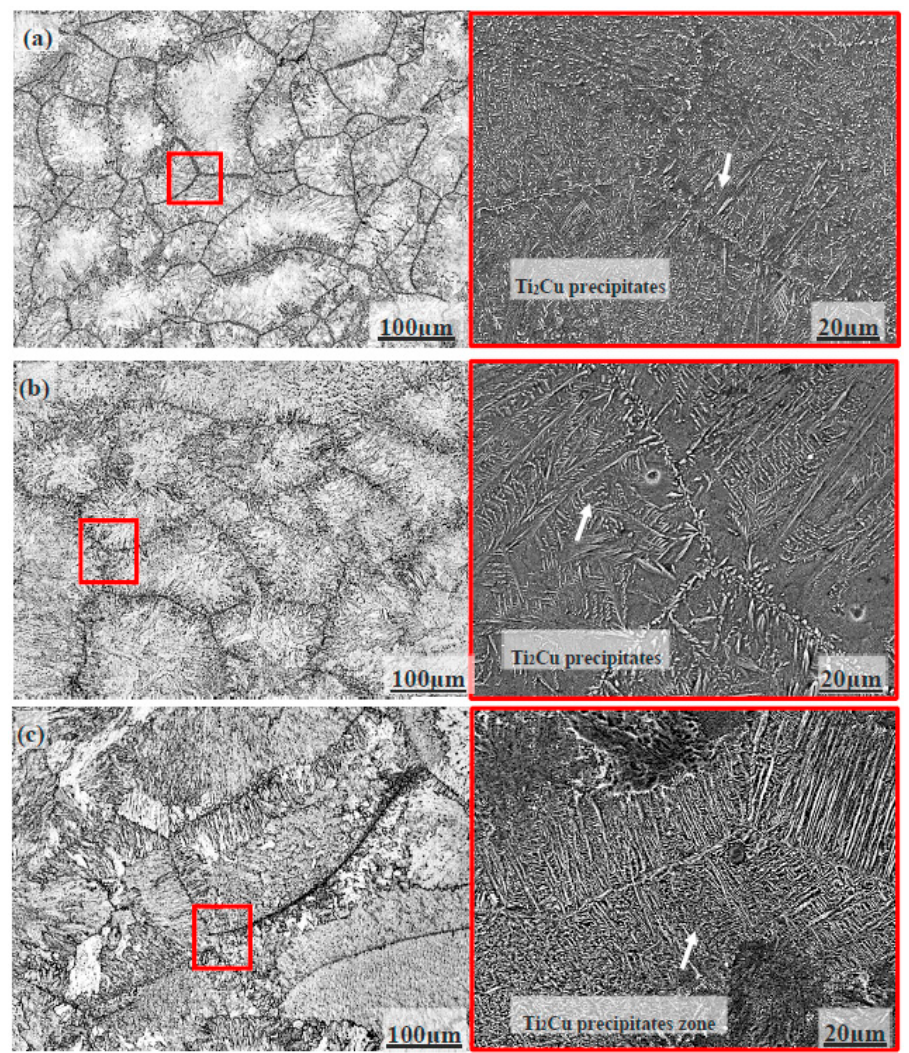
Figure 1. Microstructures of Ti14 alloy at the forging temperature of: ( a ) 1000 °C; ( b ) 1050 °C; and ( c ) 1100 °C. Right figures show the enlarged views of the grain boundaries as obtained from scanning electron microscope (SEM, JSM-6700, JEOL Company, Osaka, Japan) [33].